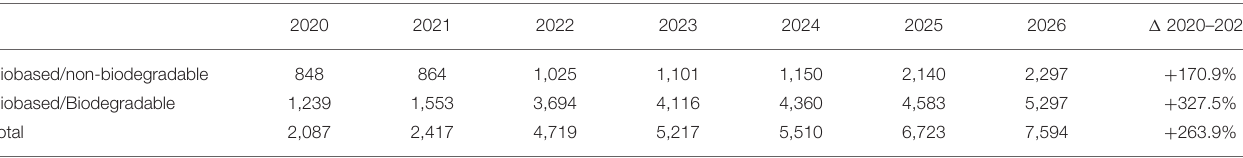
TABLE 2 | Bioplastic global production (1,000 tons): data and